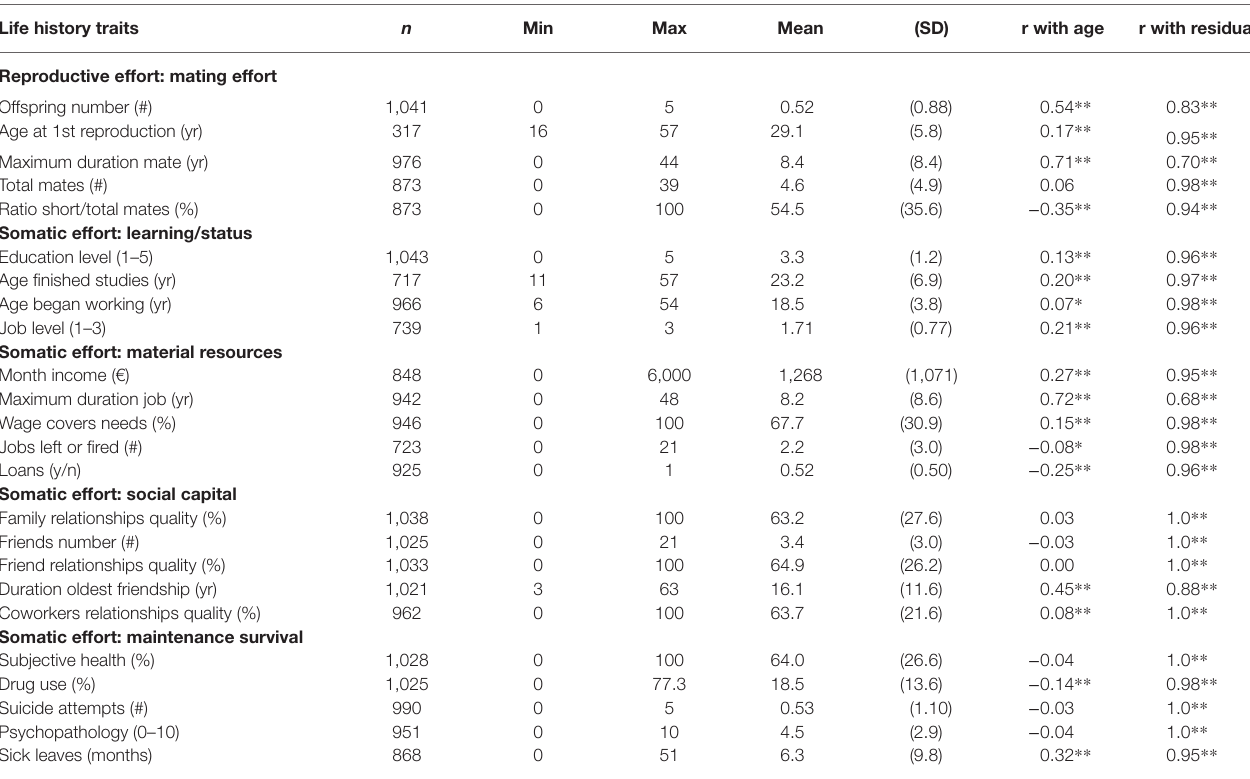
TABLE 1 | Summary statistics for LH traits and correlations with age and age-corrected residuals. Life history